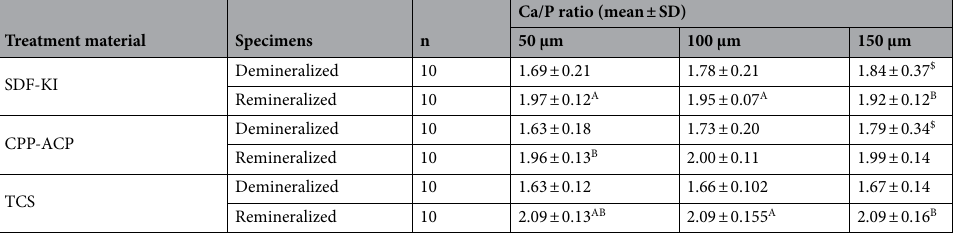
Table 3. Mean ± SD of Ca/P ratio of different groups at different levels. ABC Similar superscript capital letters in the same column denote a significant difference among different materials within the same level on the same side (demineralized/remineralized). abc Similar superscript lowercase letters in the same row denote a significant difference among different levels within the same material on the same side (demineralized/ remineralized). $ Nonsignificant difference between demineralized and remineralized sides for the same concentration in the same